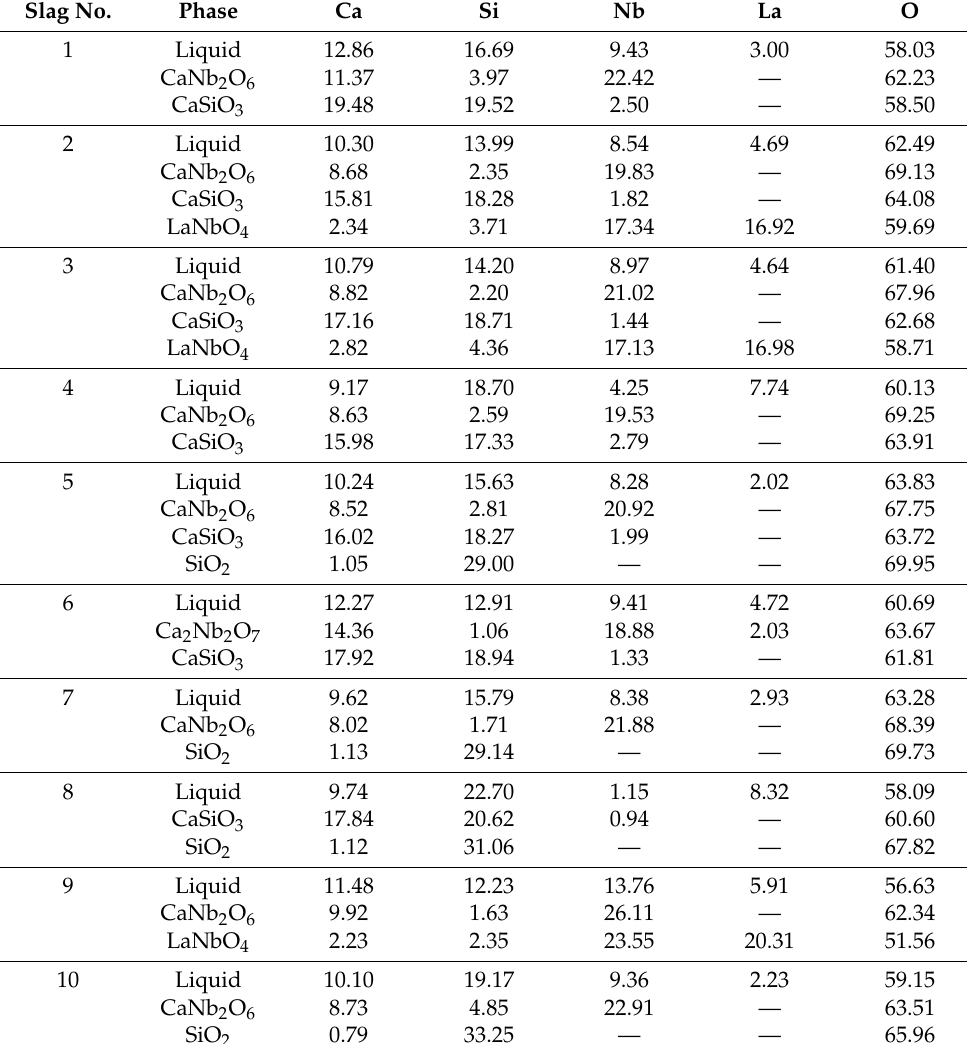
Table 3. EDS results of high temperature equilibrium experiment slags